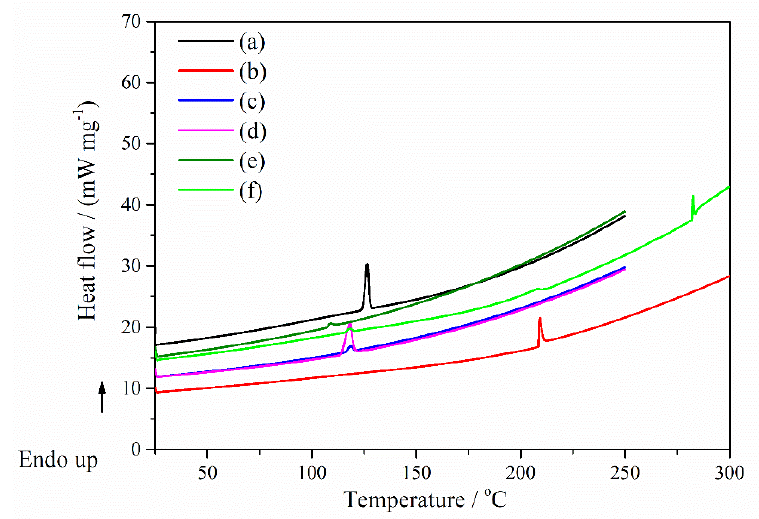
Figure 11. DSC curves of ( a ) Nim; ( b ) HP- β -CD; ( c ) Nim–HP- β -CD physical mixture; ( d ) Nim–HP- β -CD coprecipitation method; ( e ) Nim–HP- β -CD lyophilization method; ( f ) Nim–HP- β -CD kneading method.